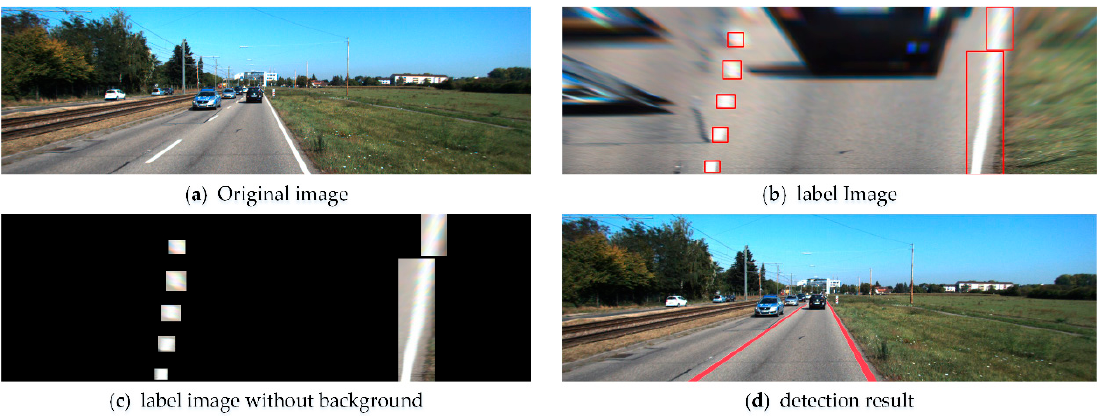
Figure 9. The lane fitting process.